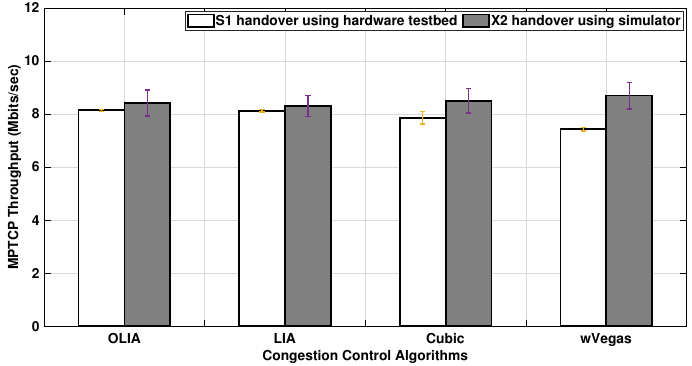
Figure 18. Setup 2 MPTCP throughput with handover for different congestion control